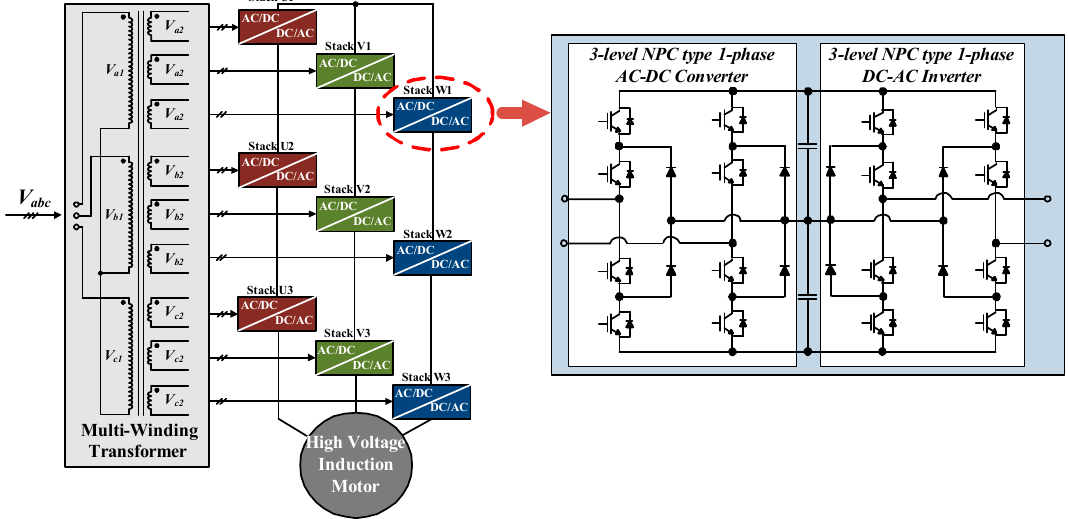
Figure 1. Configuration of 13-level cascaded NPC/H-bridge inverter with single-phase AFE (Active Front End) rectifier.